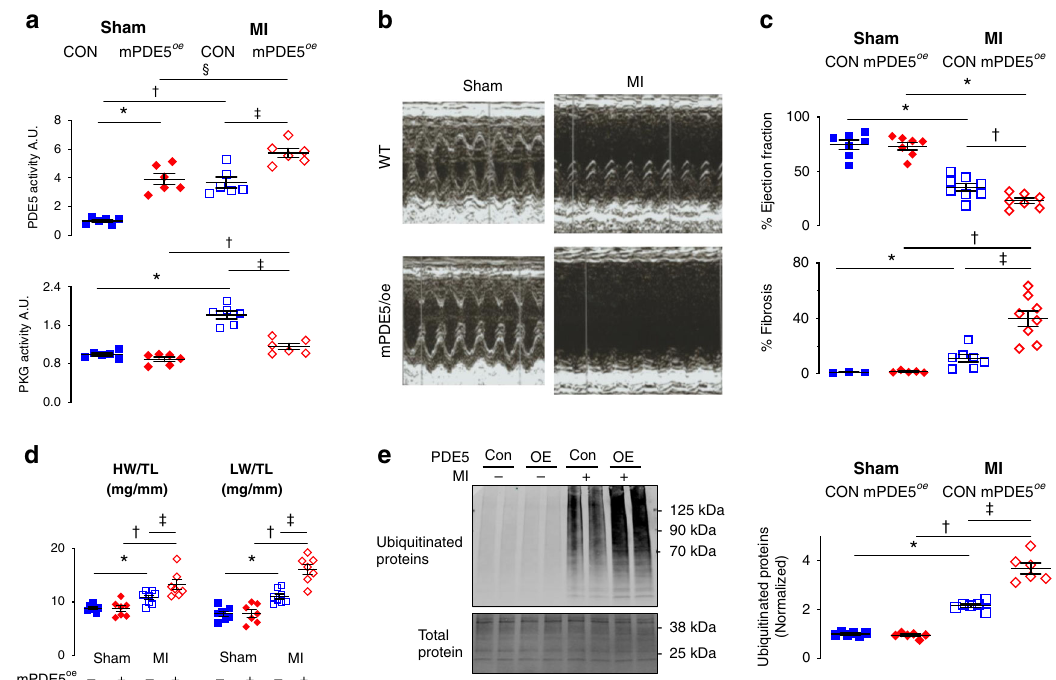
Fig. 4 Suppressed myocyte PKG activity in vivo worsens infarct remodeling. a PDE5A and PKG enzyme activity in peri-infarct region at baseline and after myocardial infarction in mice with myocyte-speci fi c PDE5A overexpression (mPDE5 oe ) versus littermate controls (CON). 2WANOVA, Tukey Post mct: Upper: *10 − 5 , † 3 × 10 − 5 , ‡ 8 × 10 − 4 , § 2.6 × 10 − 3 ; Lower: *2 × 10 − 8 , † 0.025, ‡ 9 × 10 − 7 . b Example of M-mode echocardiograms in mPDE5/ oe versus littermate controls 1-week following myocardial infarction (MI). c Summary data for left ventricular ejection fraction (EF, n = 7 – 8 mice/group) and for fi brosis ( n = 3 – 8 biological replicates/group) for same study. For EF: Repeated measures mixed effects model, Holm-Sidak mct: * p < 2 × 10 − 8 ; † p = 0.03; for fi brosis: biological replicates: 3 – 5 – sham, 7 – 8 MI; Brown-Forsythe Welch ANOVA, Dunnetts mct: * p = 0.02, † 0.008, ‡ 0.003. d Heart and Lung weight normalized to tibia length for same study (HW/TL, LW/TL respectively). N = 7 – 8 biological replicates; 2WANOVA, Sidaks mct: for HW/TL: * p = 0.04, † 2 × 10 − 5 , ‡ 0.01; LW/TL: *0.003, † 8 × 10 − 9 , ‡ 2 × 10 − 5 . e Ubiquitinated protein increase after MI in the peri-infarct zone is greater in mPDE5/ oe hearts. N = 6 biological replicates, 2WANOVA, Tukey mct: *8.6 × 10 − 6 , ‡ <10 − 8, ‡ 1.5 × 10 − 7 . Source data are provided as a Source Data fi le. Individual data and mean ± SEM shown in each summary